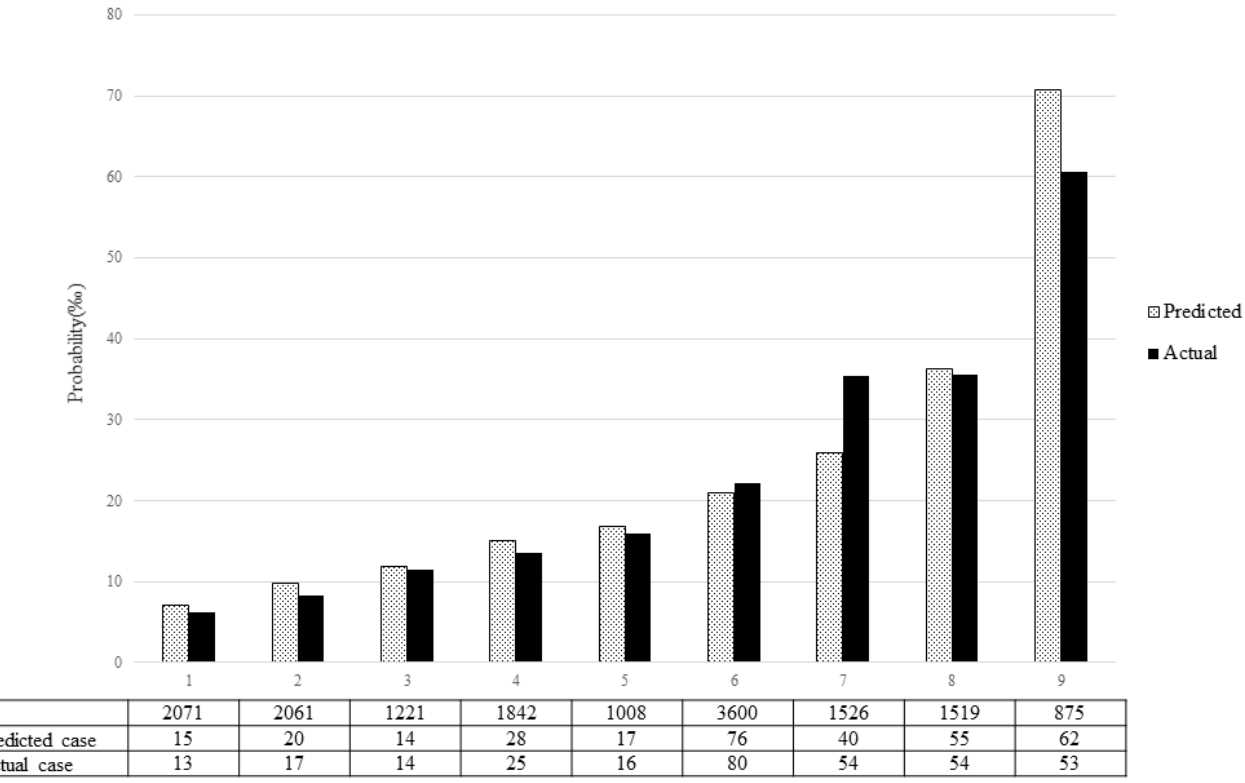
Figure 4. Calibration plot. The x -axis represents nine quantiles of predicted risk, and the y -axis reveals predicted and actual probability of birth defects.